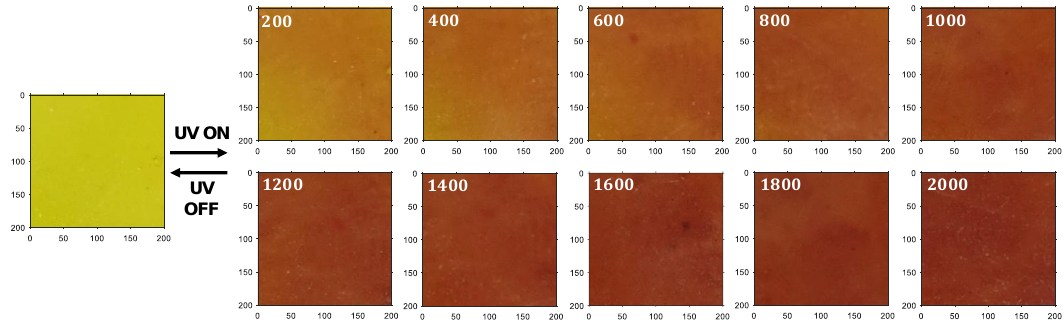
Figure 7. Cropped images from original colorimetric responses for digital image processing.